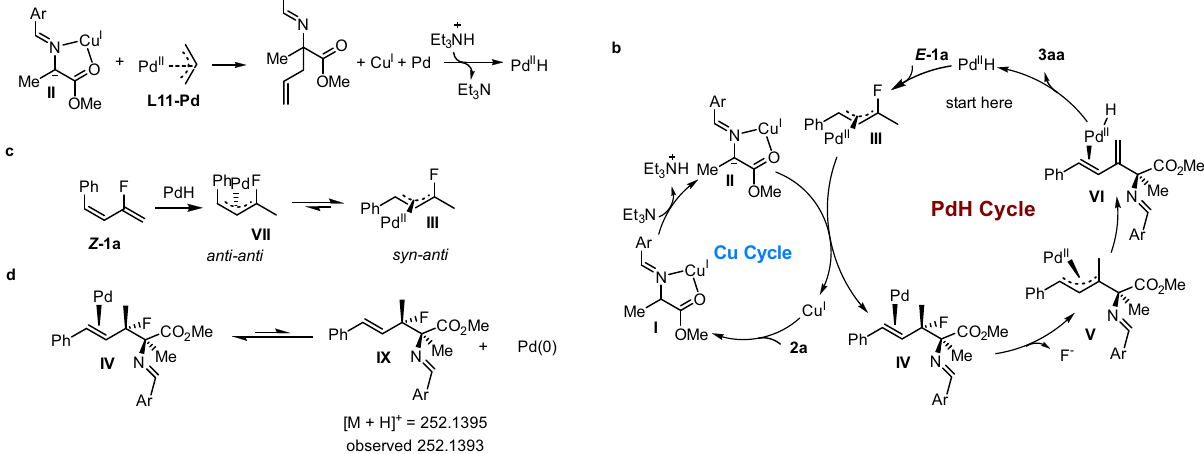
Fig. 6 Proposed mechanism. a Initial generation of PdH catalyst from the precatalyst L11-Pd . b Proposed catalytic cycle. c Isomerization of anti - anti π -allyl-Pd to syn - anti π -allyl-Pd. d HRMS detection of [M + H] + for Intermediate IX. The ligands were omitted for clarity. groups ( 3ah – 3aj ), revealing that the reaction was not sensitive to the steric bulk of the ester. An aldimine ester derived from glutamic acid also reacted smoothly but gave lactam 3ak in 58% yield with 92% ee, as a result of cyclization during the acidic workup. α -Amino- γ -butyrolactone derived imine underwent reaction with NATURE COMMUNICATIONS| (2022) 13:2470